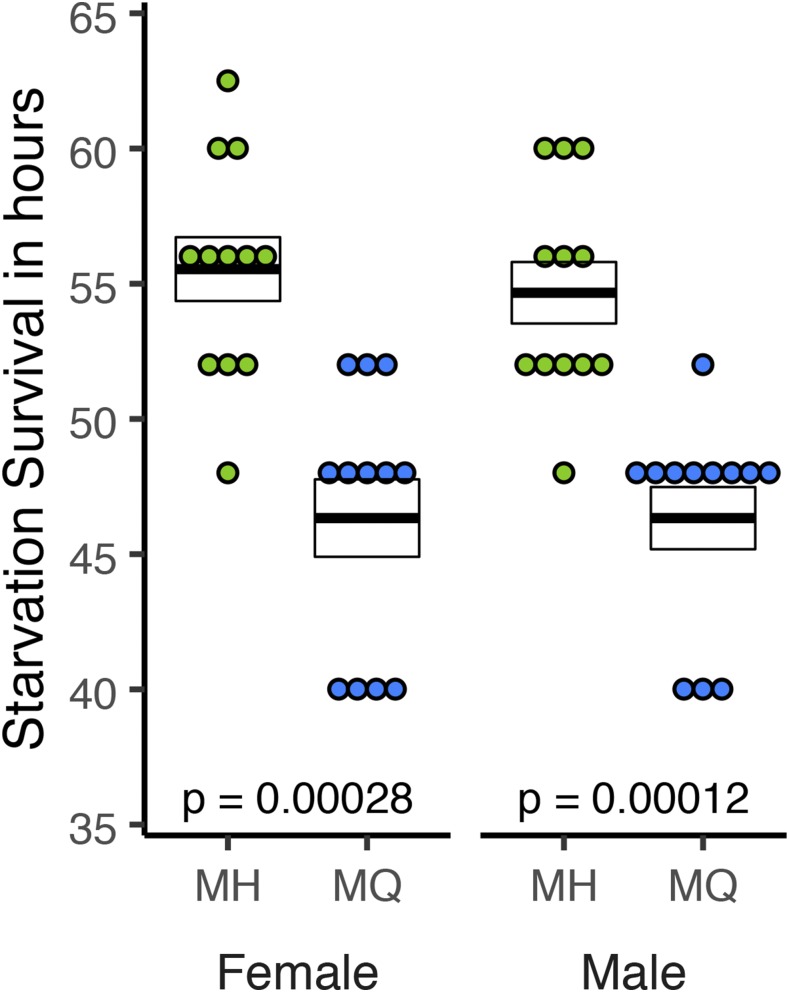
Starvation resistance was measured for adult female and male flies. Each point represents the time in hours until the death of one individual. Crossbars represent mean ± SE; p-values correspond to a Wilcoxon test on MH vs. MQ for each sex. Sample sizes are all n = 12.